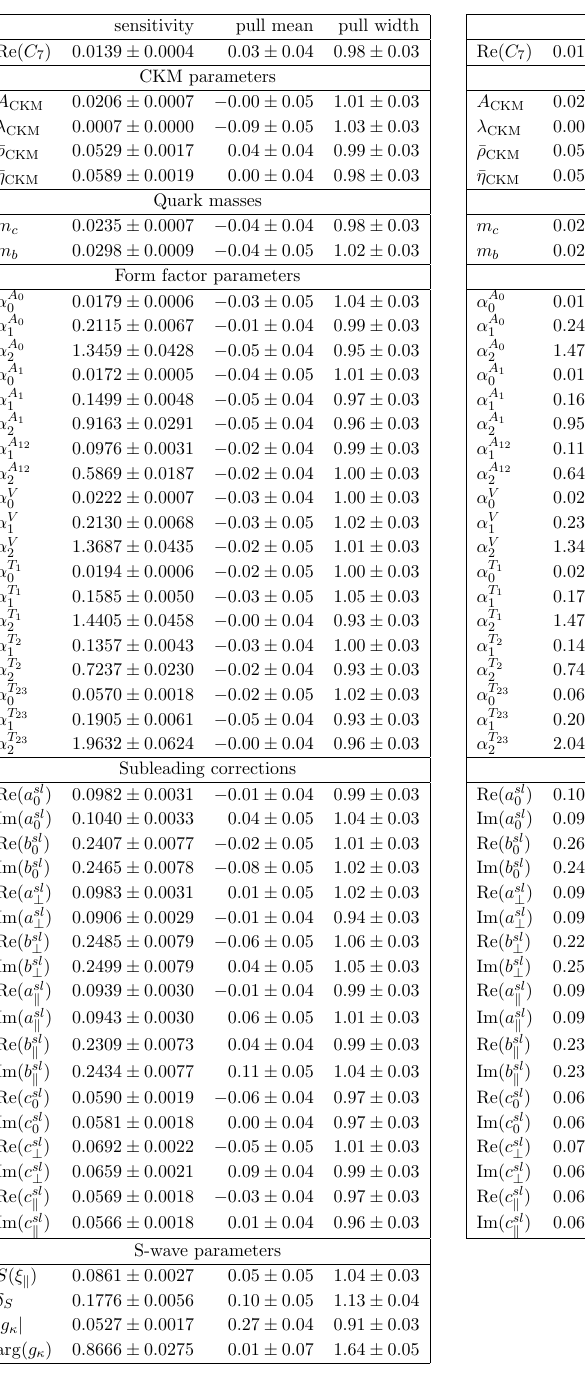
Table 5. Results from pseudoexperiments determining Re( C 7 ) using (left) the proposed direct (cid:12)t method and (right) the q 2 -binned